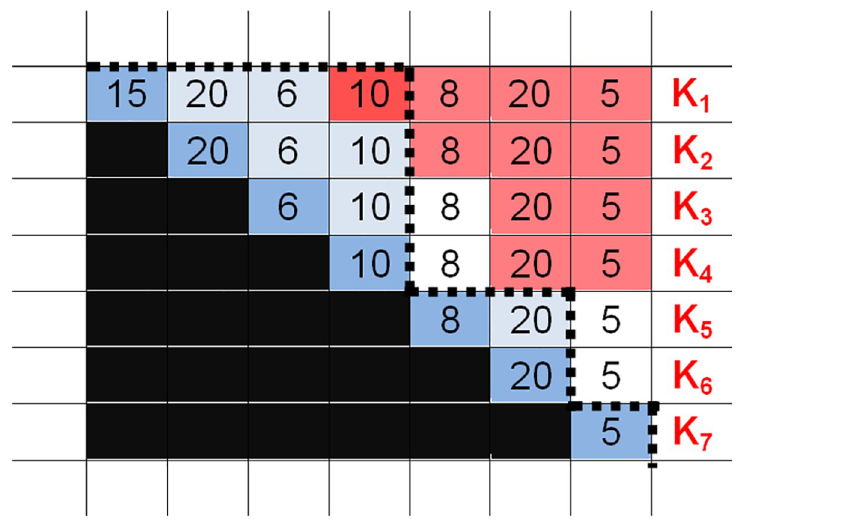
Fig 6. The area of an irrational order in an EPP